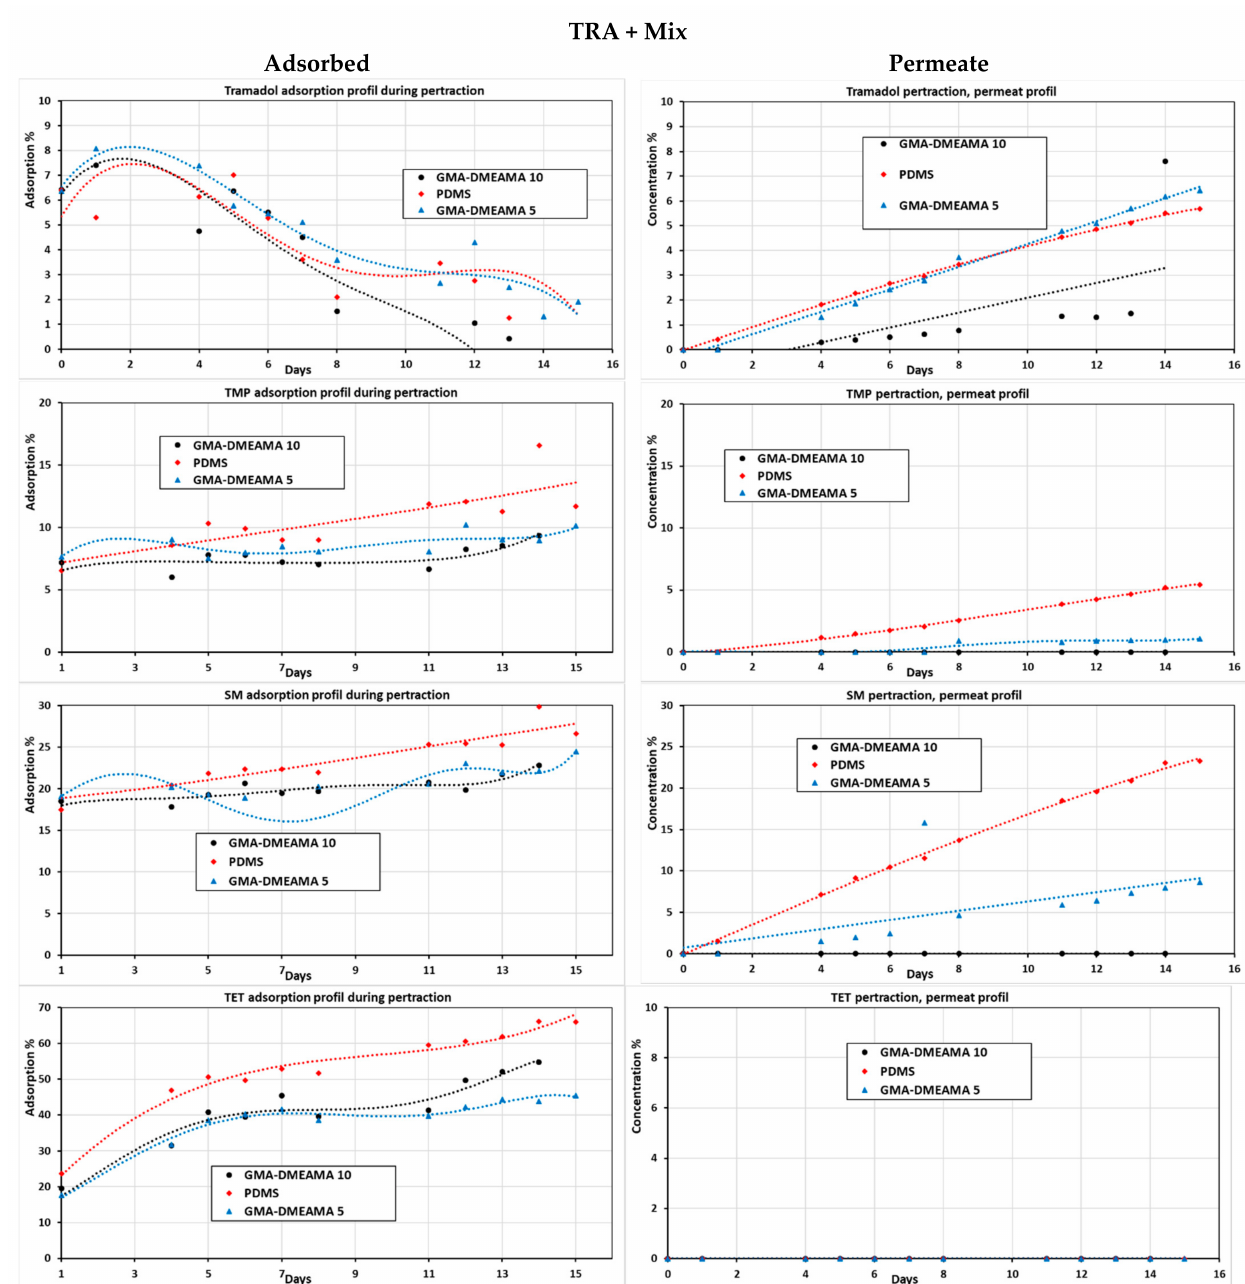
Figure 9. Adsorption and permeate profiles of tramadol, trimethoprim, sulfamethoxazole, and tetracycline together in the model solution of the pertraction process with bare and GMA-DMAEMA-modified PDMS